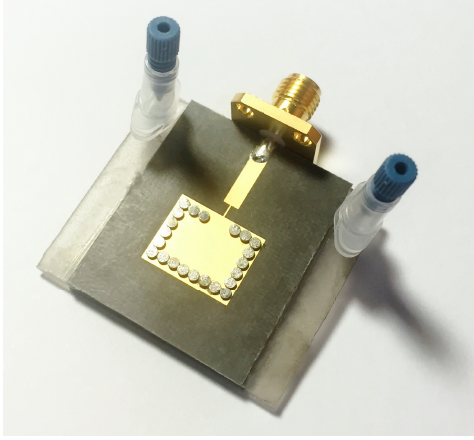
Figure 6. Photograph of the fabricated prototype.